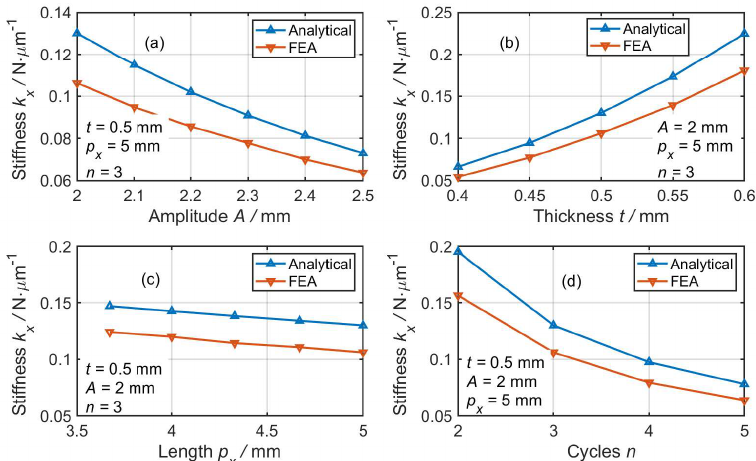
Figure 2. The x -axis stiffness k x of the sinusoidal corrugated flexure hinge related to ( a ) amplitude A , ( b ) thickness t , ( c ) length p x , and ( d ) cycle number n